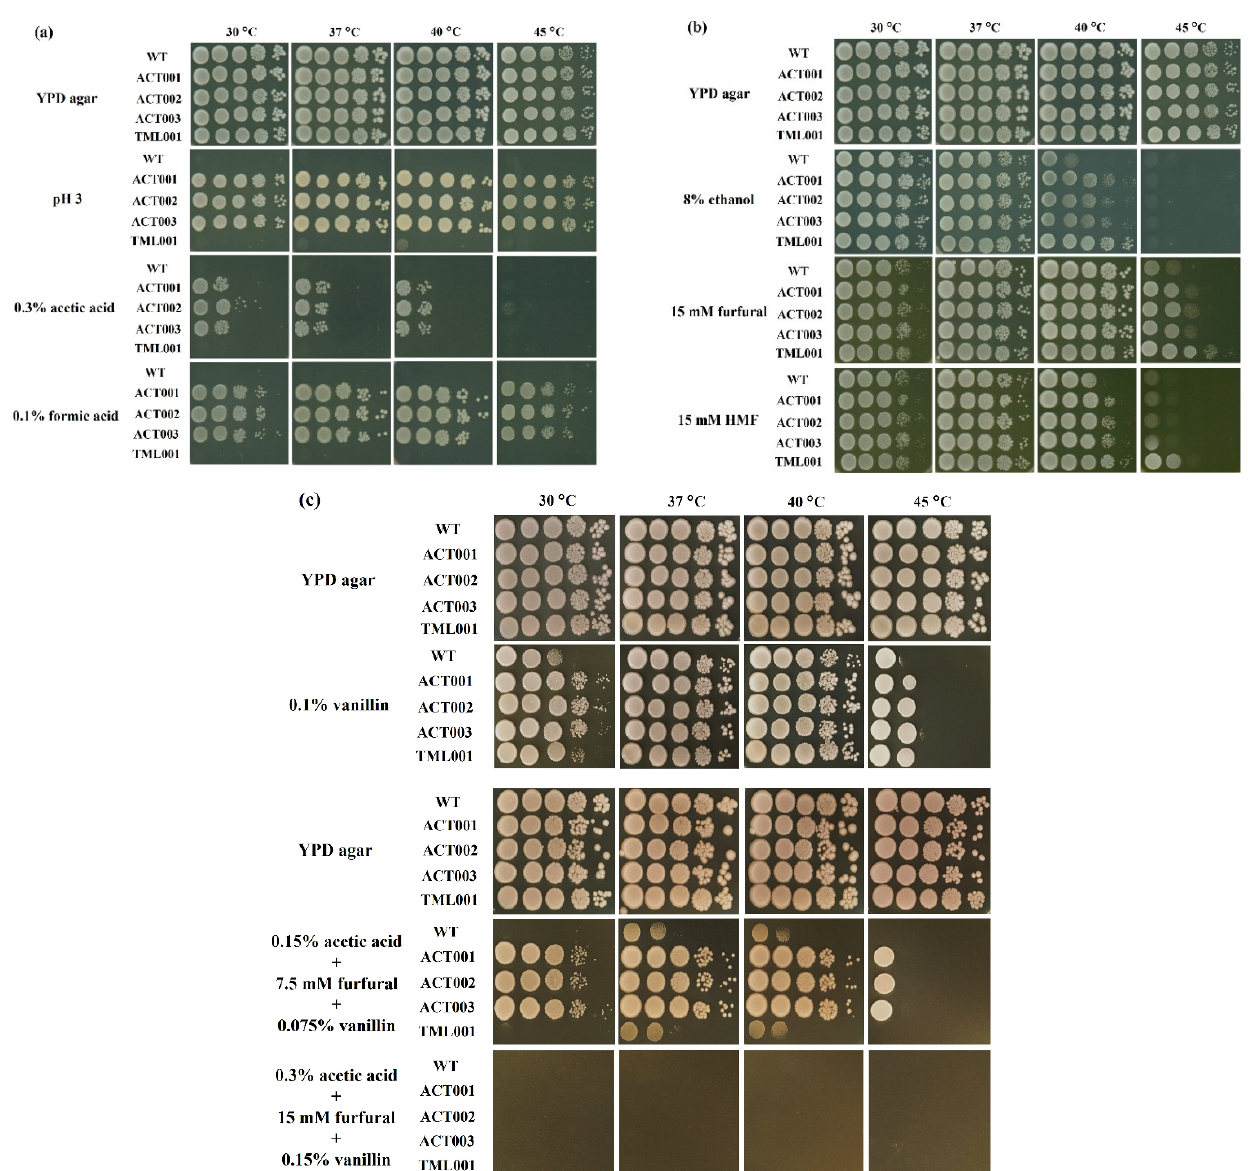
Figure 3. Characterization of adapted strains. Growth of adapted strains on YPD agar plates with pH adjusted to 3 or supplemented with 0.3% acetic acid, 0.1% formic acid ( a ), 8% ethanol, 15 mM furfural, 15 mM HMF ( b ), 0.1% vanillin or multiple inhibitors (0.15% acetate, 7.5 mM furfural and 0.075% vanillin or 0.3% acetate, 15 mM furfural and 0.15% vanillin) ( c ) were compared. The plates were incubated at 30–45 °C for 48 h.